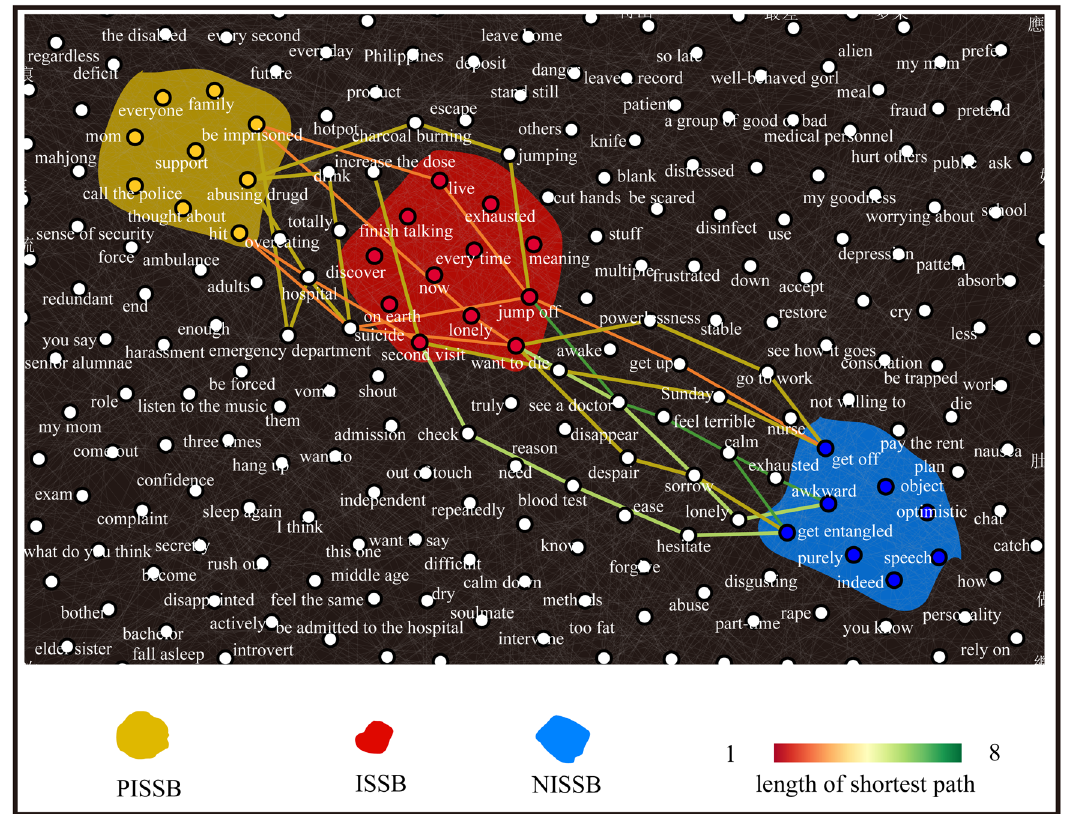
Fig. 3 Illustration of 18 shortest paths. We arbitrarily selected three nodes in each of the three randomly sampled block modules which consist of a PISSB module (yellow), a ISSB module (red), and a NISSB module (blue). Paths between the three arbitrary nodes of the PISSB module and the three arbitrary nodes of the ISSB module are shown, resulting in nine paths. Same procedure was conducted for NISSB-ISSB node pairs, resulting in the other nine paths. See Supplementary Notes for the bilingual version of this fi